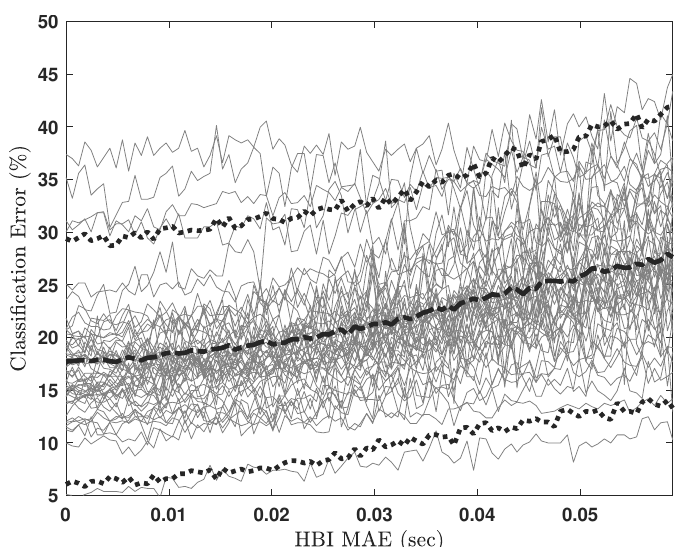
Figure 7. SVM classification error due to all HRV features for macro-labeled sleep stages. Light gray lines represent classification errors for each participant. The dashed, bold black line is the ensemble average, and the dotted bold lines show mean +/ − 1.96 standard deviations.